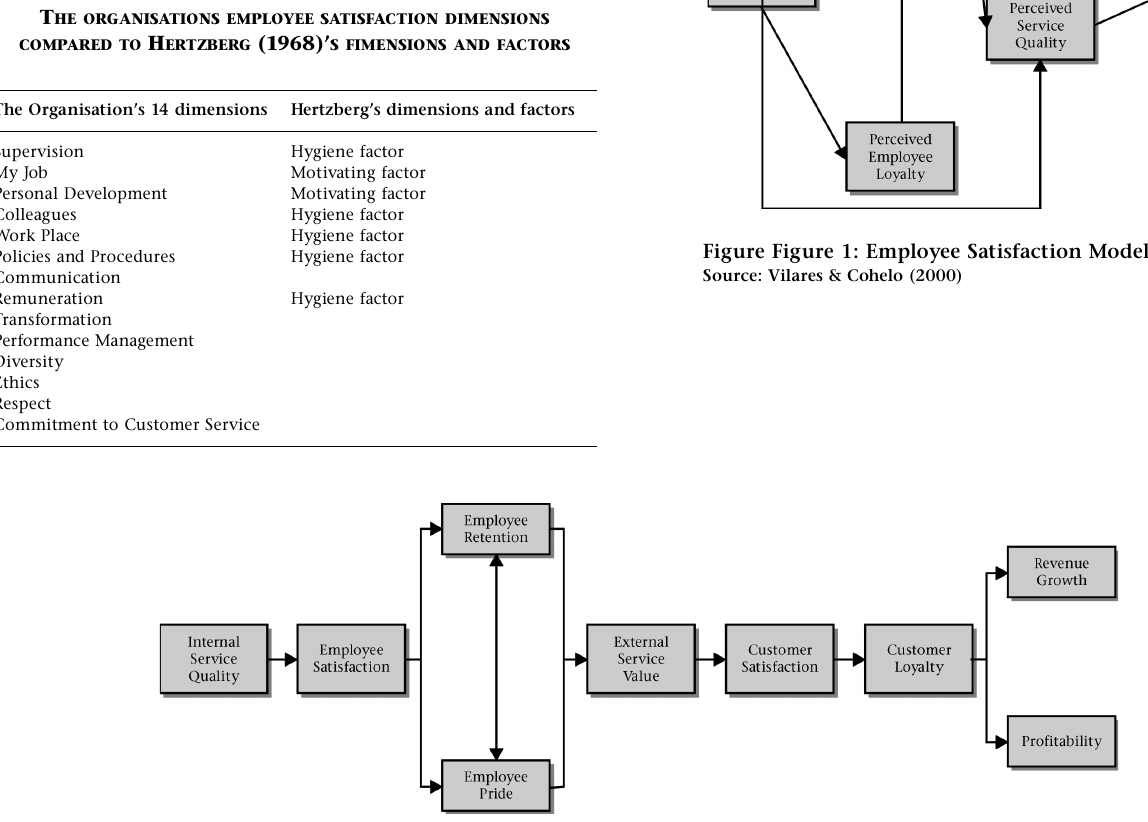
Figure 2: The Service Profit Chain Source: Heskett, Sasser, Jr & Schlesinger